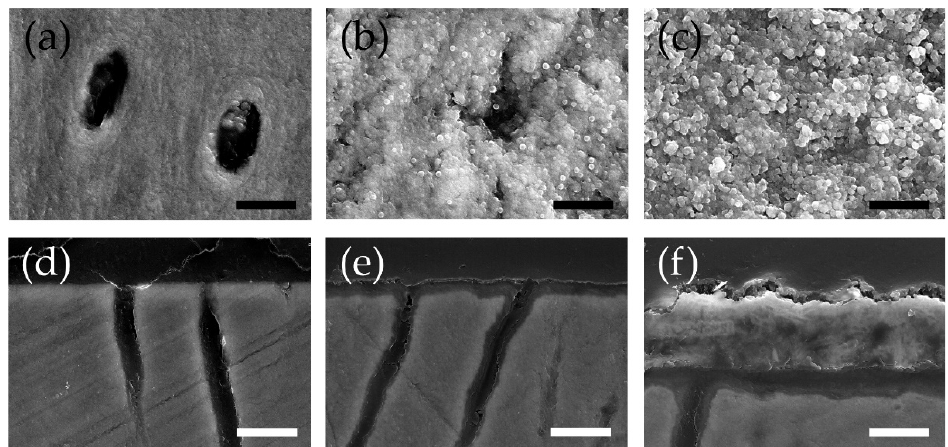
Figure 3. Images of surface and cross-section scanning electron microscope (SEM) observations after acid challenge. The top images show surface SEM observations taken at 10,000 magnifications. From the left, ( a ) control group, ( b ) APF group, and ( c ) BioHap group. The black scale bar represents 2.5 µ m. The lower images show cross-section SEM observations taken at 5000 magnifications. From the left, ( d ) control group, ( e ) APF group, and ( f ) BioHap group. The white scale bar represents 5.0 μ m.